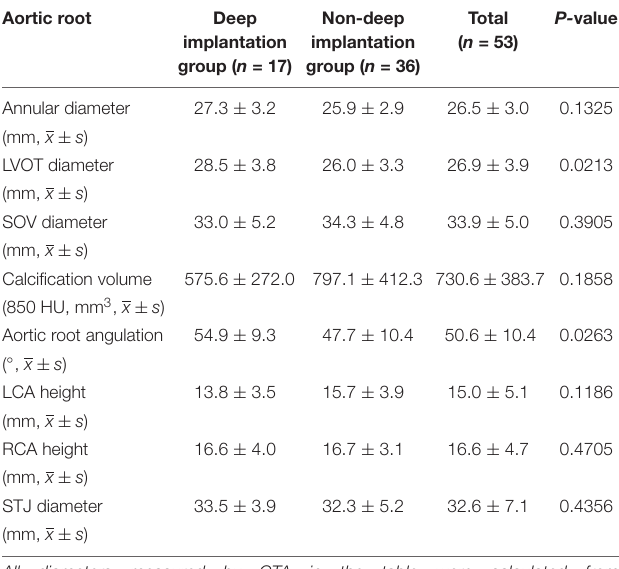
TABLE 2 | Comparison of aortic root computerized tomography angiography (CTA) measurements between the deep implantation group and the non-deep implantation group of the Venus-A